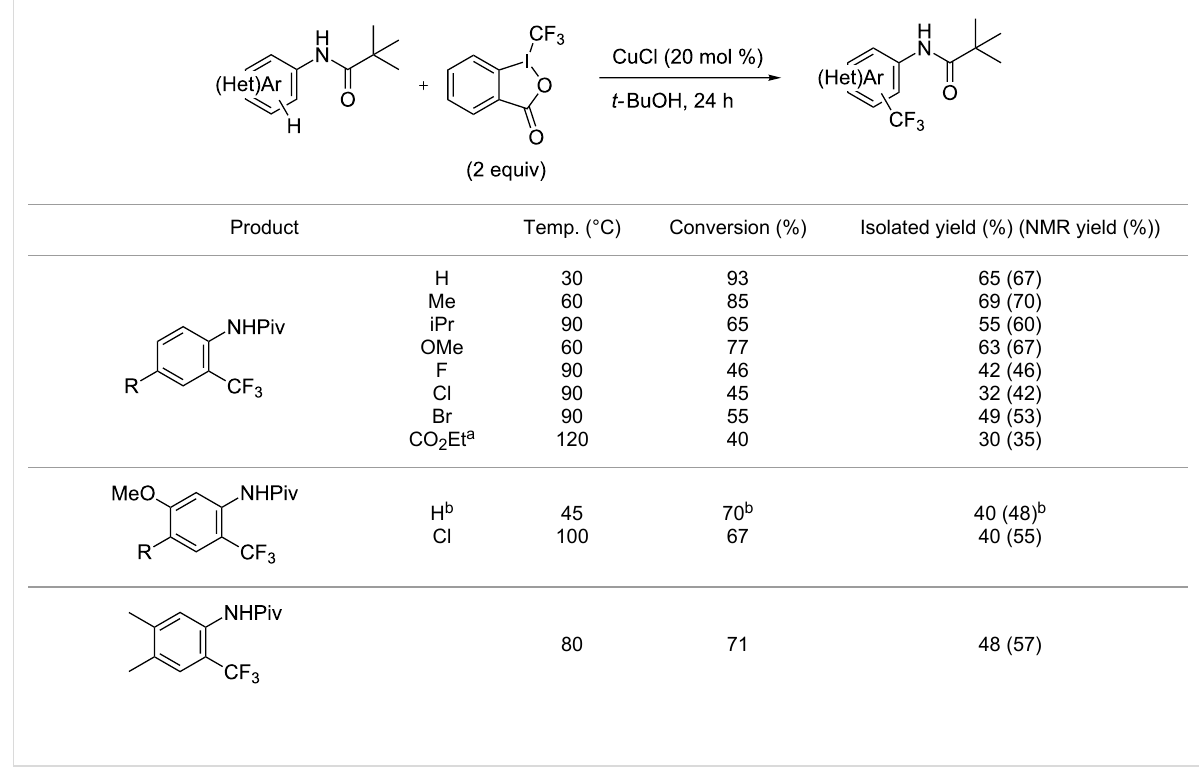
Table 17: Cu-catalyzed C–H functionalization of pivanilides [84].